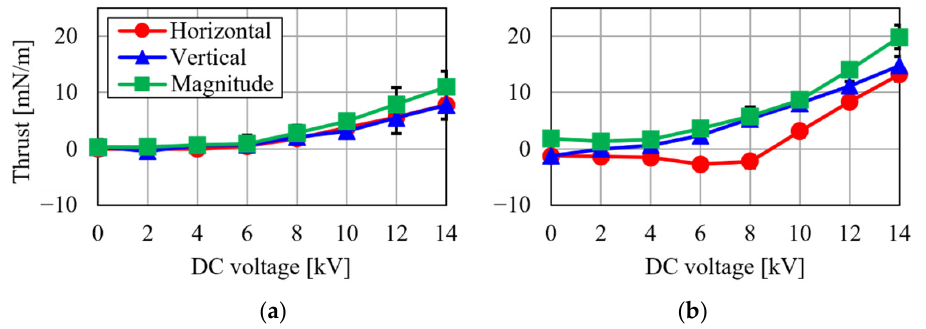
Figure 14. Thrust versus the DC voltage when the AC voltage was 10 kV pp at 4 kHz in the ( a ) CD-PA and ( b ) TED-PA.